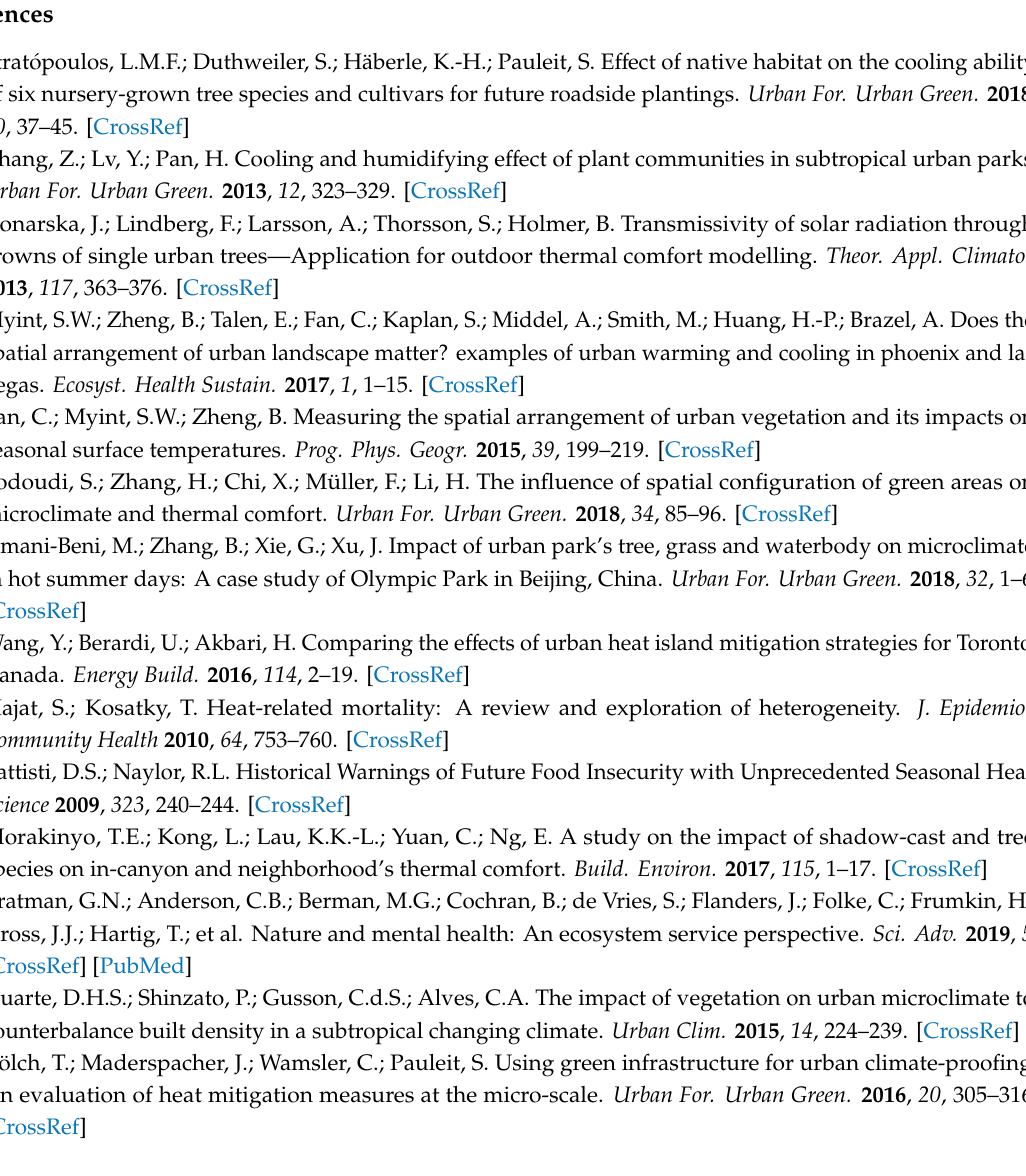
transpiration characteristics of urban trees with di ff erent configuration modes. (a) E and cooling e ff ect; (b) G s and cooling e ff ect; (c) Vpd L and cooling e ff ect; (d) E and humidifying e ff ect; (e) G s and humidifying e ff ect; (f) Vpd L and humidifying e ff ect. IP: individual planting; LP: linear planting; GP: group planting; E: transpiration rate; G s : stomatal conductance. Figure S4: Microclimate regulation and transpiration characteristics of ET and DT. (a) E and cooling e ff ect; (b) G s and cooling e ff ect; (c) Vpd L and cooling e ff ect; (d) E and humidifying e ff ect; (e) G s and humidifying e ff ect; (f) Vpd L and humidifying e ff ect. ET: evergreen tree species; DT: deciduous tree species; E: transpiration rate; G s : stomatal conductance; Vpd L : vapor pressure